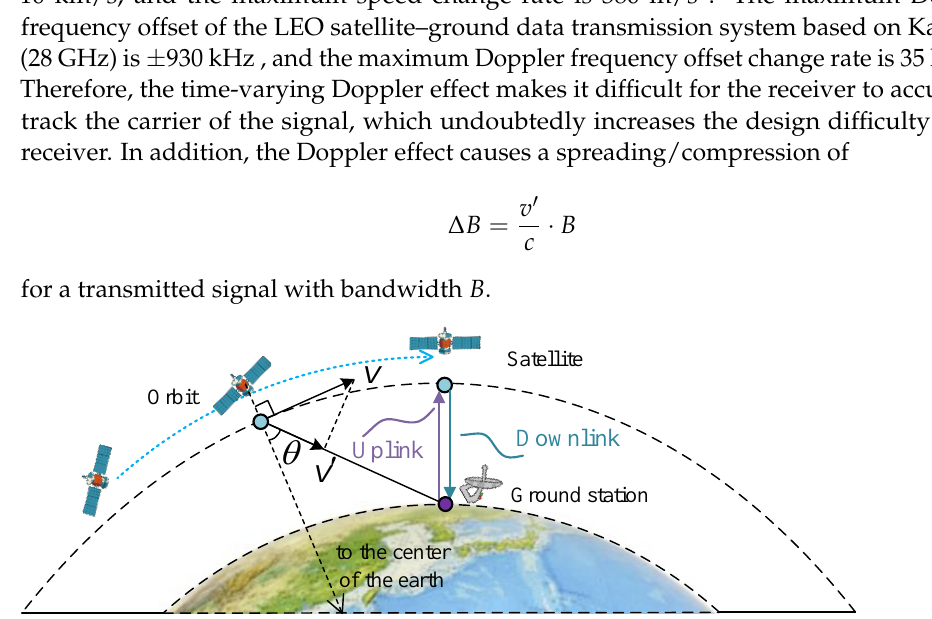
Figure 3. Schematic diagram of the distance variation of LEO satellite–ground data transmission